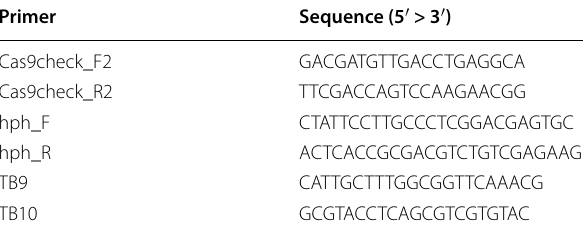
Table 2 Primers used in this study Primer Sequence (5 ′ > 3 ′